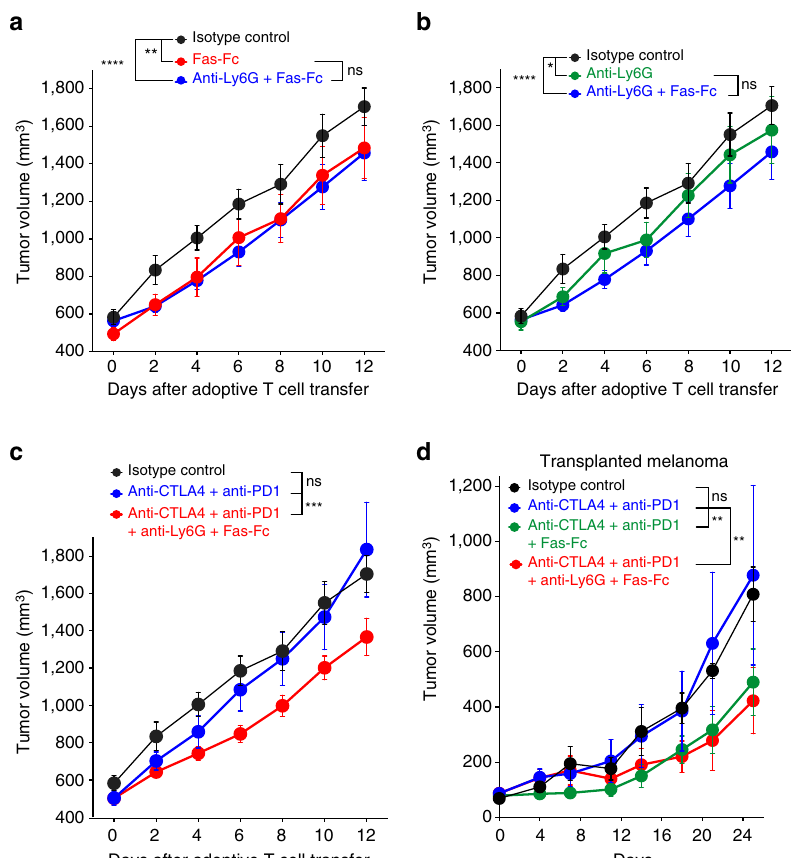
Fig. 8 FasL neutralization increases the ef fi cacy of immunotherapy. a , b Mice bearing Amela TiRP tumors received i.p. injections of soluble Fas-Fc and/or anti-Ly6G antibody, starting when tumor size reached 500 mm 3 , and repeated twice a week. ACT was applied 3 days after the fi rst injection, and tumor volume was monitored (Mean ± s.e.m, n = 10 mice/group). c Mice treated as in ( a , b ) received anti-CTLA4 and anti-PD1 antibodies i.p. 1 day after the fi rst injection of Fas-Fc/anti-Ly6G, and then twice a week for a total of four injections (Mean ± s.e.m; isotype: n = 10; CTLA4/PD1: n = 9; CTLA4/PD1/Ly6G/ Fas-Fc: n = 10; this experiment was run together with the one described in ( a , b ) and the isotype control group is identical). d Mice bearing transplanted melanomas T429.11 received i.p. injections of anti-Ly6G and/or Fas-Fc starting when tumors became palpable, and repeated twice a week. 1 day later they received i.p. injections of anti-CTLA4 and anti-PD1, repeated twice a week for a total of four injections (Mean ± s.e.m; isotype: n = 7; CTLA4/PD1: n = 7; CTLA4/PD1/Fas-Fc: n = 10, CTLA4/PD1/Ly6G/Fas-Fc: n = 10; data pooled from two independent experiments). Depletion of Ly6G + cells in tumors was checked after killing a – d . Two-way ANOVA a – d , * P < 0.05, ** P < 0.01, *** P < 0.001, **** P <